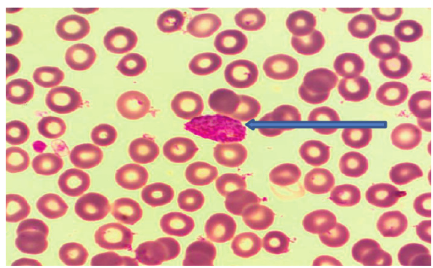
Figure 2: Schizont of Plasmodium vivax .